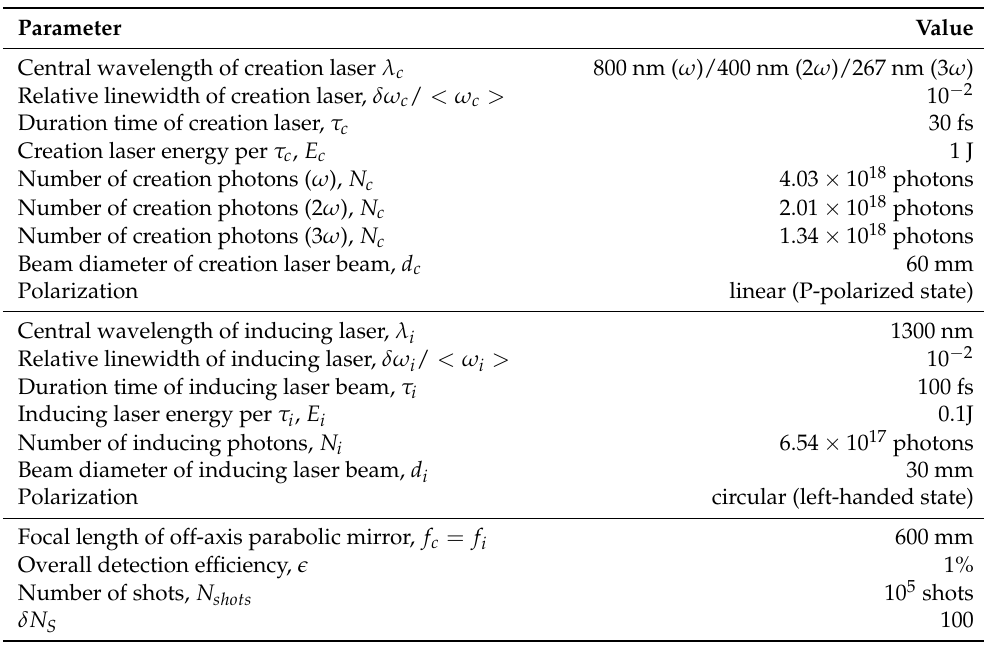
Table 1. Experimental parameters used to numerically calculate the upper limits on the coupling– mass